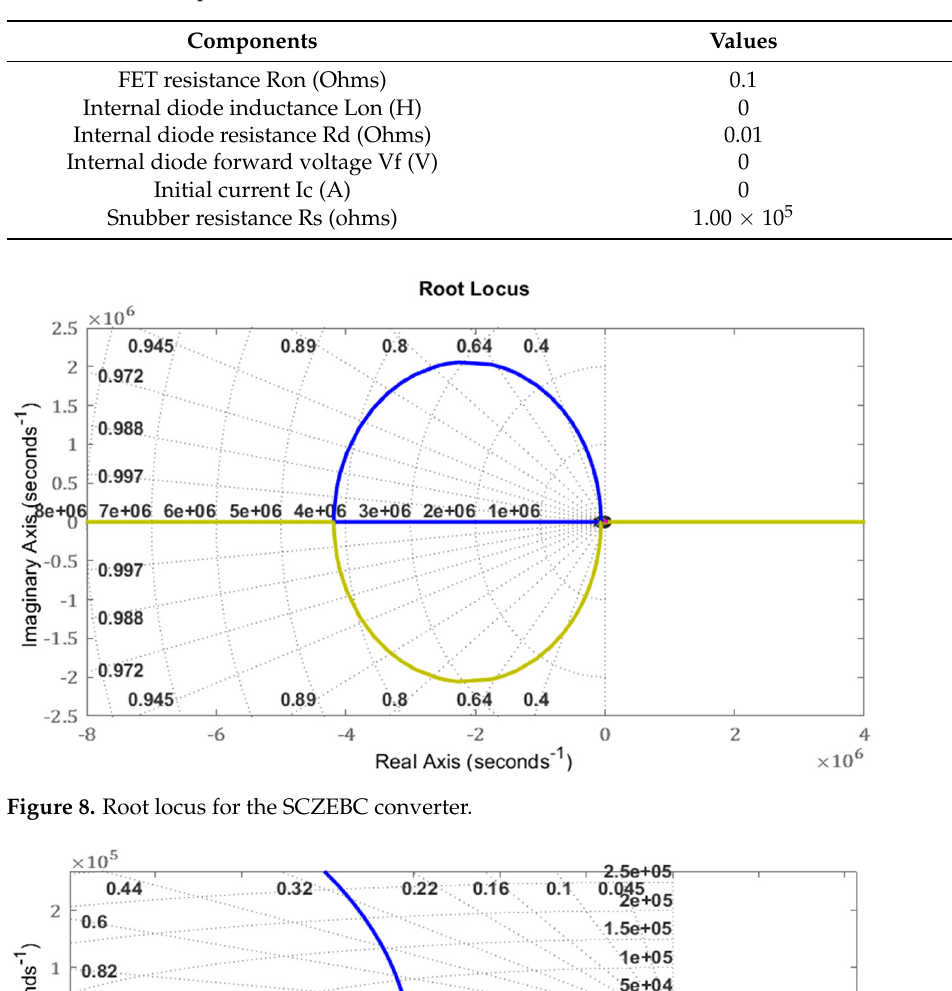
Table 7. MOSFET specifications of the converter.